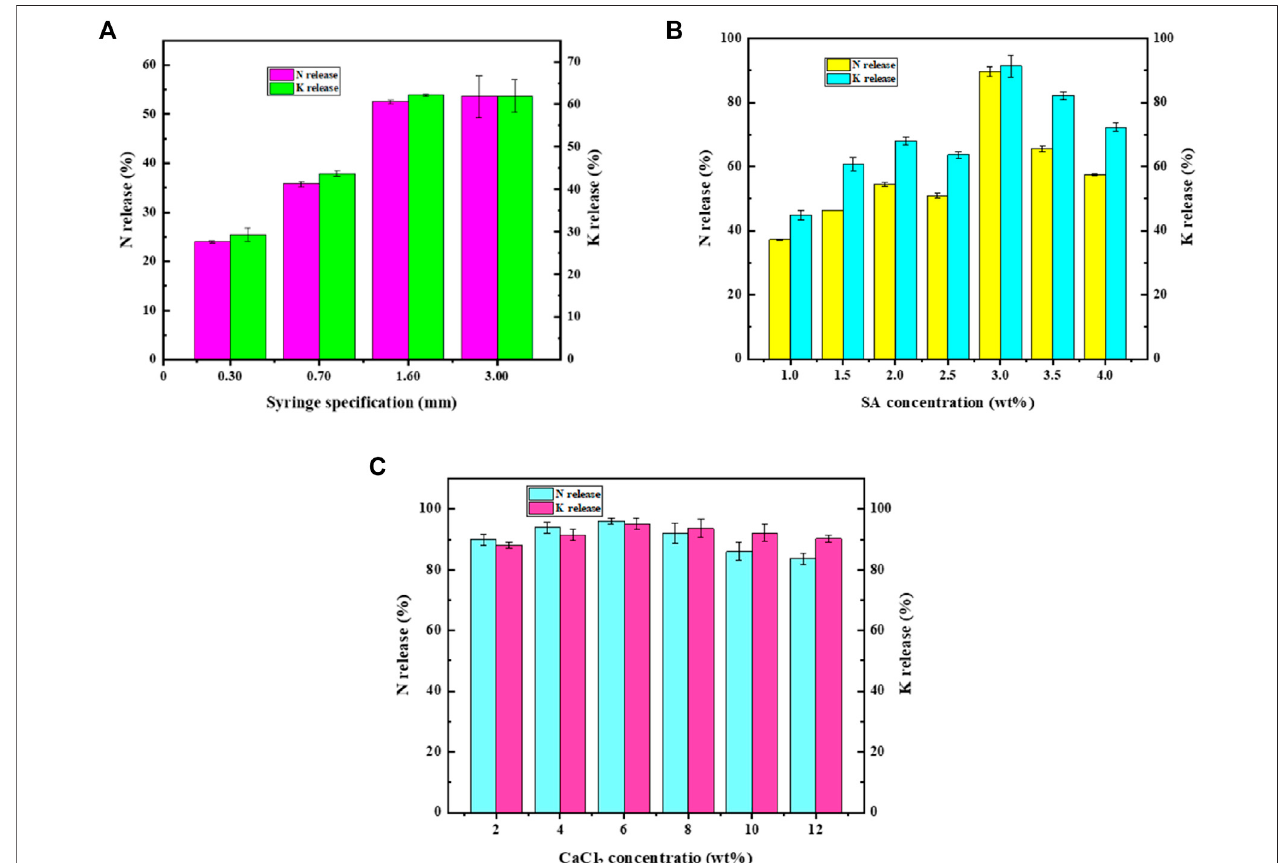
FIGURE 3 | Effects of different factors on the release of nutrients. (A) Sizes of GM. (B) SA concentration. (C) CaCl 2 concentration.